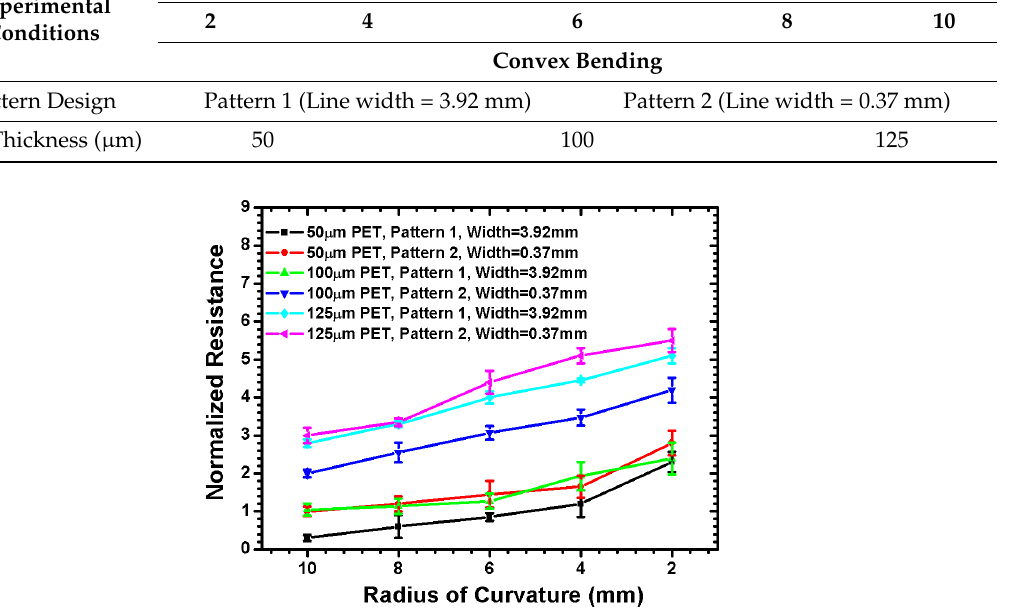
Table 2. Experiment conditions designs of patterned ITO/PET film.